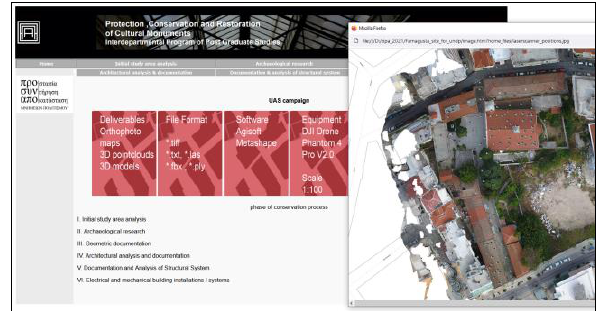
Figure 11 . Layout of the multimedia application (presentation of Geometric documentation / UAS campaign / Example: Orthophoto map).